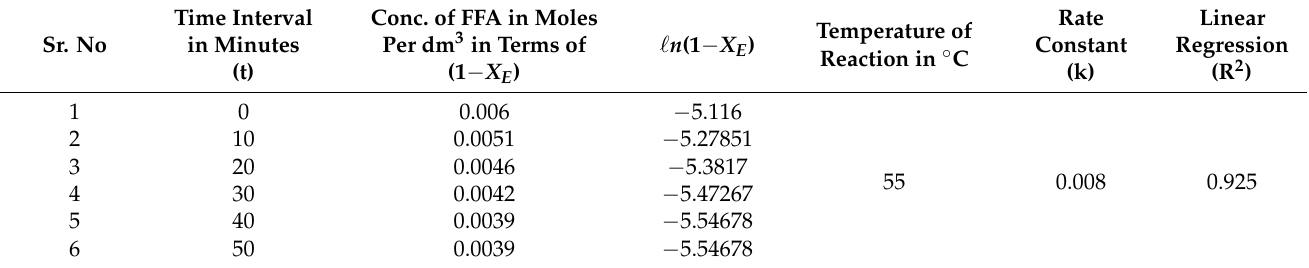
Table 3. Change in the concentration of FFA with time; intervals expressed in minutes.